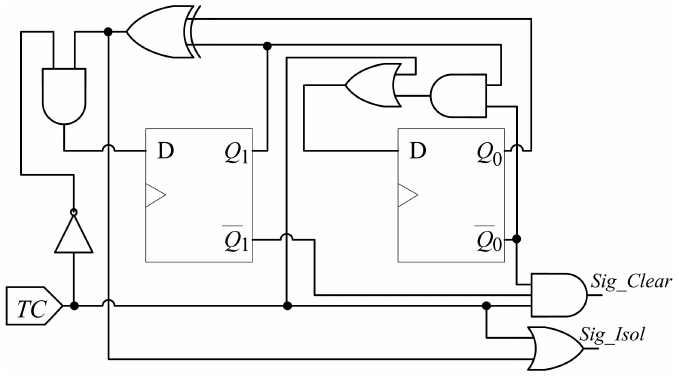
Figure 4. Architecture of the automatic test control unit.